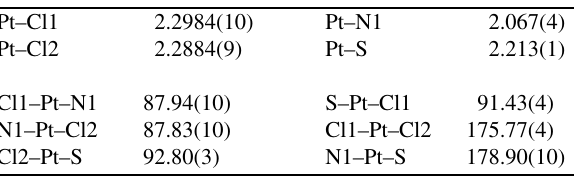
Table 2. Relevant structural parameters (Å, °) in the title com- pound.